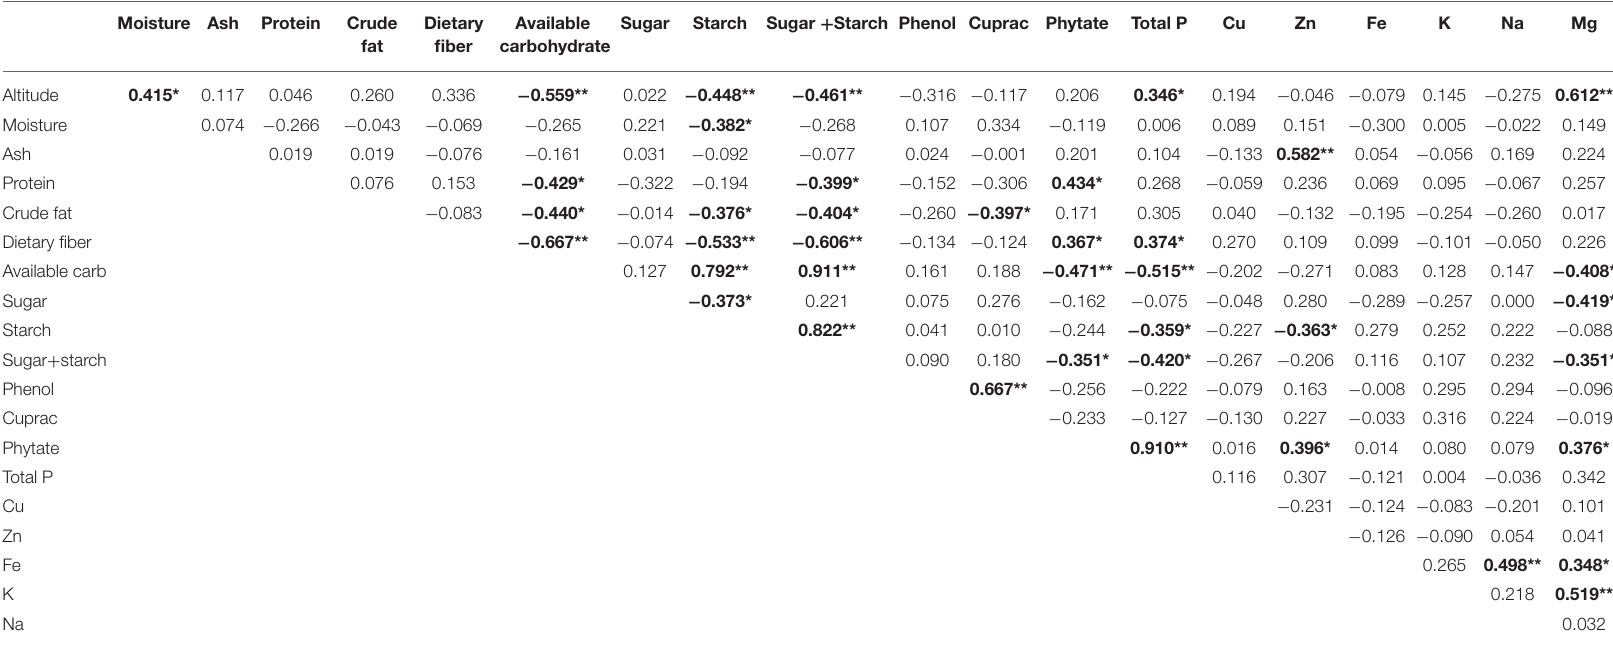
TABLE 3 | Pearson correlation between different nutrient components and altitude in native maize